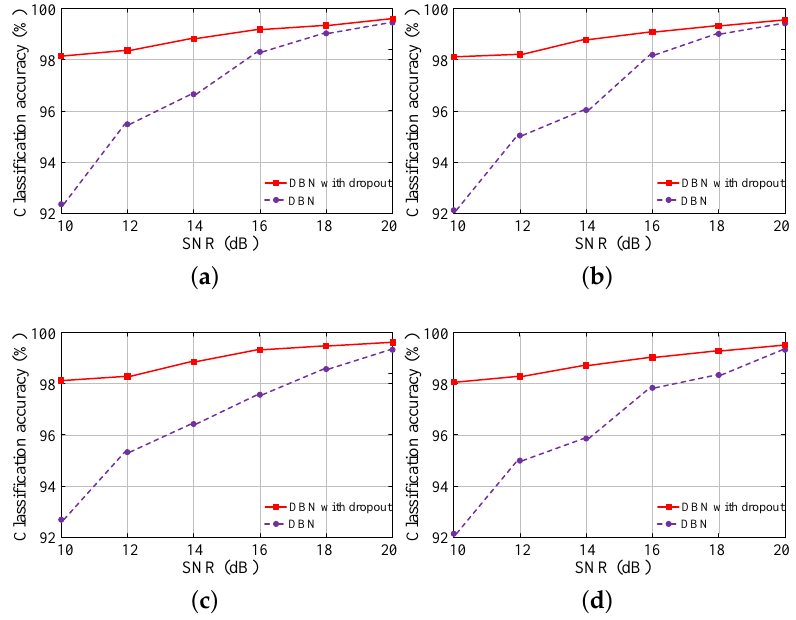
Figure 14. Classification accuracy of the proposed classifier with and without the dropout strategy at different SNR levels for the ( a ) grid-tied radial, ( b ) grid-tied loop, ( c ) islanded radial, and ( d ) islanded loop mode operation of the considered